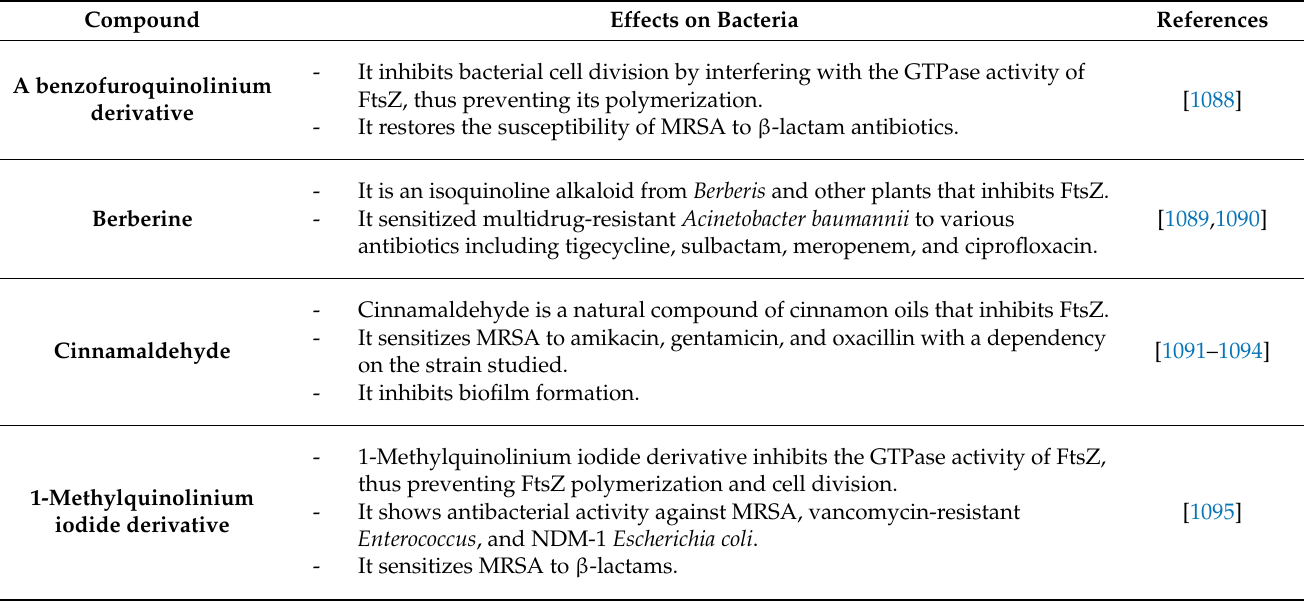
Table 8. Examples of compounds targeting cell division